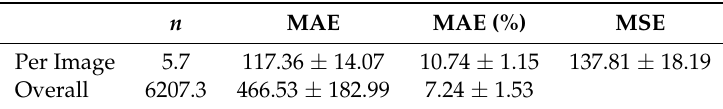
Table 7 collects results for GBCNet tested on CR2 dataset with 3-CV. Considering single images predictions with an average of 1113.9 berries per picture, the model reaches a MAE of 117.36 berries for each validation fold (10.74%). The overall MAE obtained comparing the cumulative sum of predictions and ground truth (6288.3 berries in average for each fold) results in lower value, i.e., 466.53 (7.24%), benefiting from the balancing effect of over- and underestimation when aggregating predictions. Table 7. Application of GBCNet on CR2 dataset with 3-CV. The n column refers to the average number of images and berries per fold